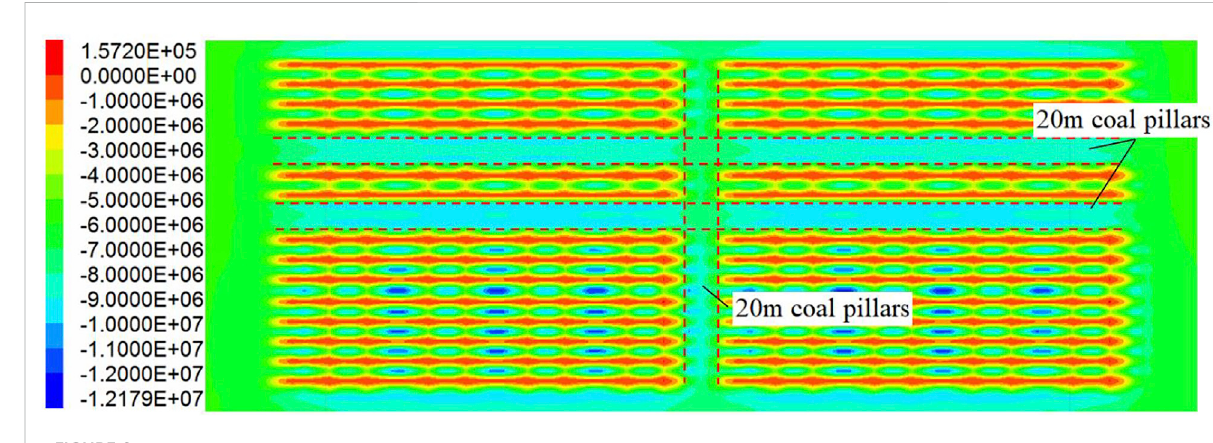
FIGURE 9 Vertical stress distribution of strata at 4 m on top of 3# coal seam (Pa).